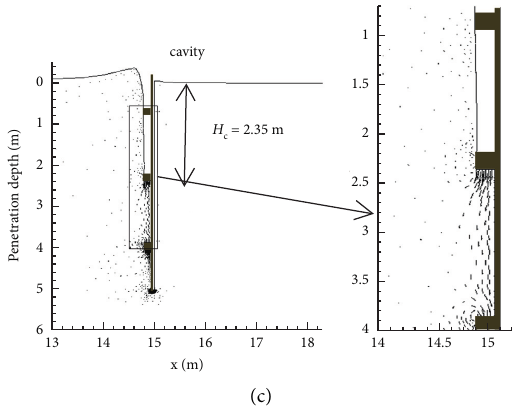
Figure 6: Soil movement of square stiffened caisson